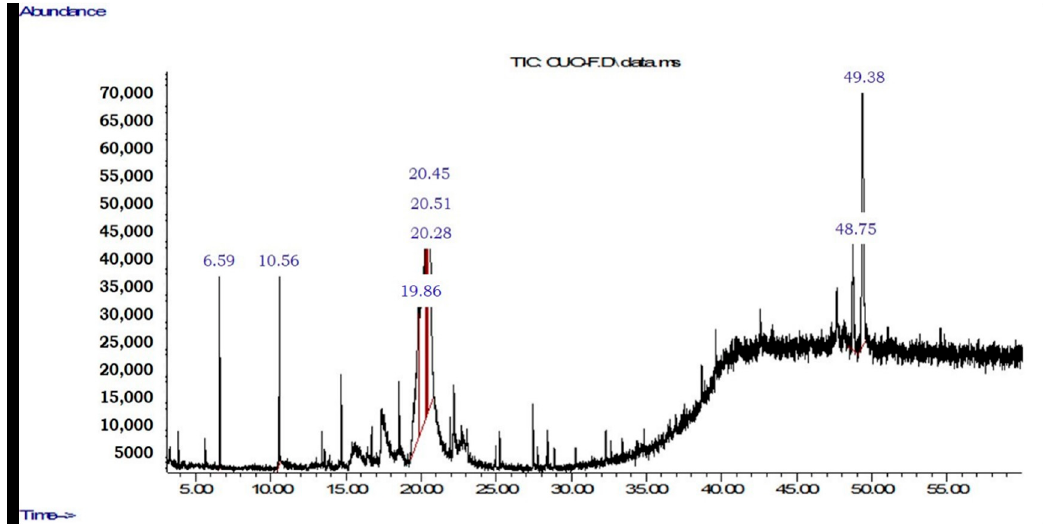
Figure A1. Dipteryx odorata leaves extract chromatogram.